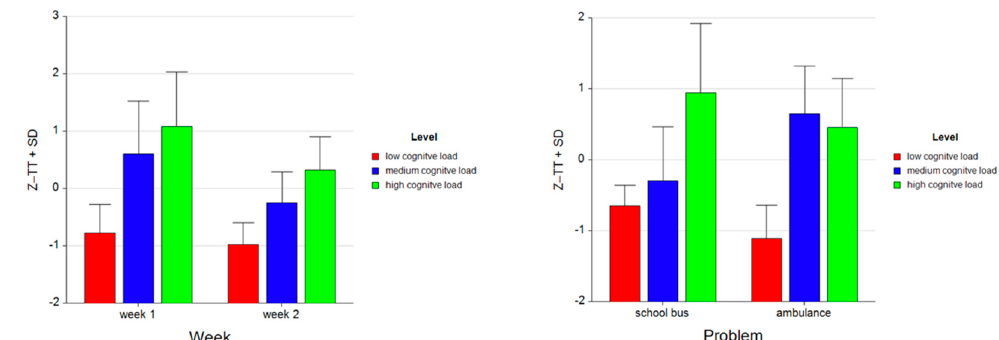
Figure 7. Bar charts represent the average standardized z-scores for total time (Z-TT) and standard deviation (SD) for low cognitive load, medium cognitive load, and high cognitive load tasks for Week 1 and Week 2 (left) and for School Bus and Ambulance problem scenarios (right).